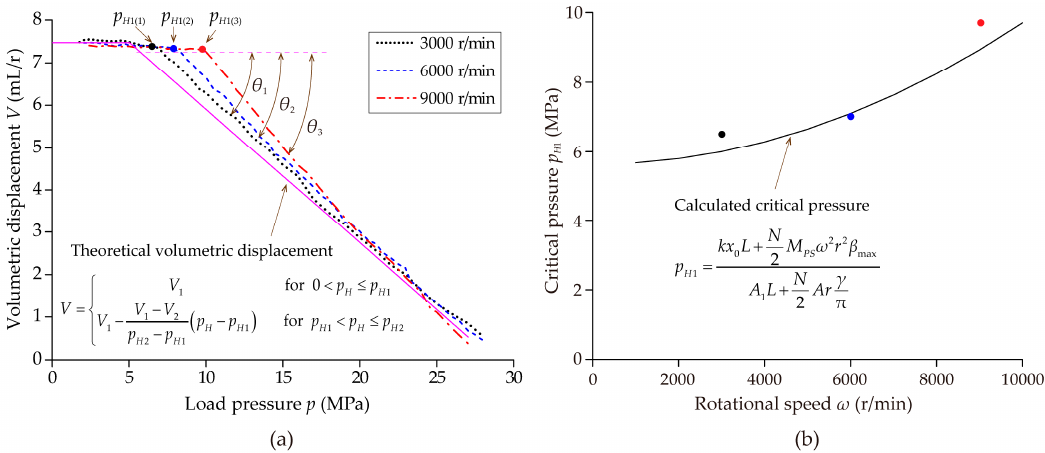
Figure 6 . Influence of rotational speed on the p - V curve: ( a ) Experimental p - V curves; ( b ) Variation of the critical pressure with rotational speed.